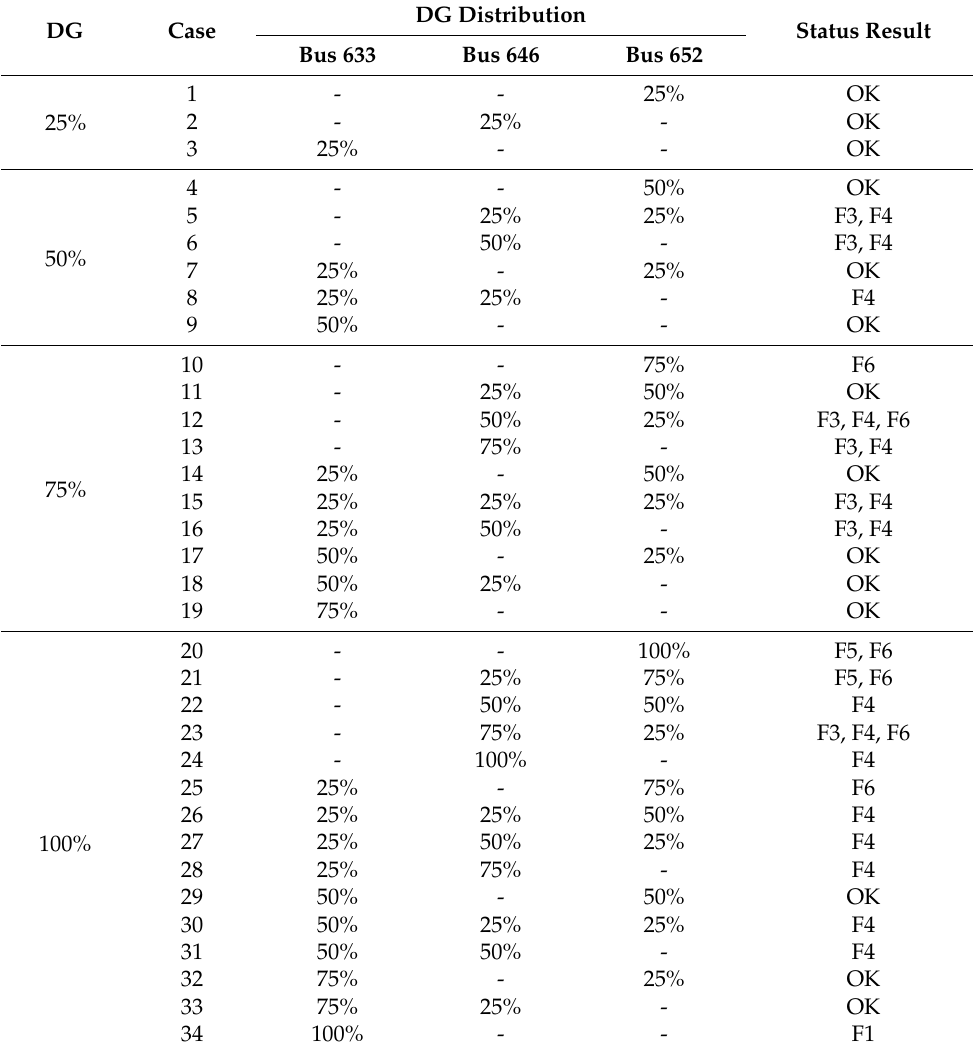
Table 6. IEEE 13-bus feeder system (Figure 6), simulated considering PV nodes. The status result (either “OK” when no fuse was tripped, or including the unexpected tripped fuses) of the different cases related to DG power penetration level and its distribution among the 3 DG installed (bus nodes 633, 646, and 652) are included in the